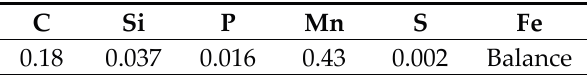
Table 1. Chemical composition of BM.